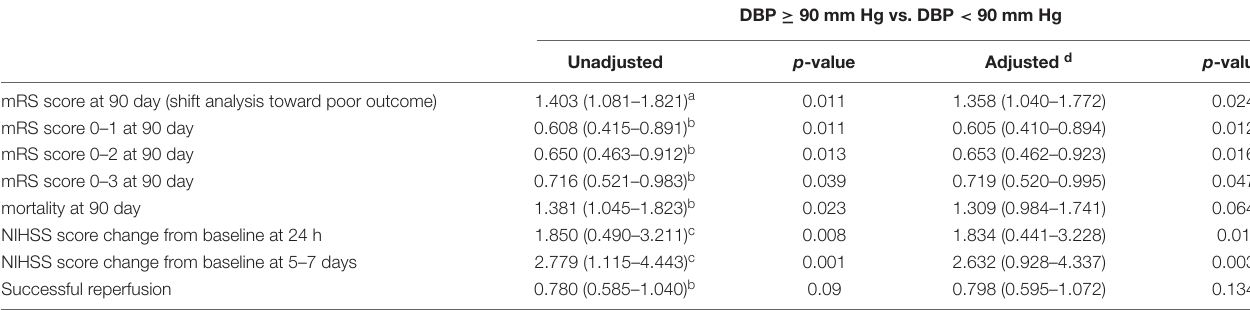
TABLE 4 | Association of baseline DBP with clinical and radiographic outcomes in univariable and multivariable analysis.